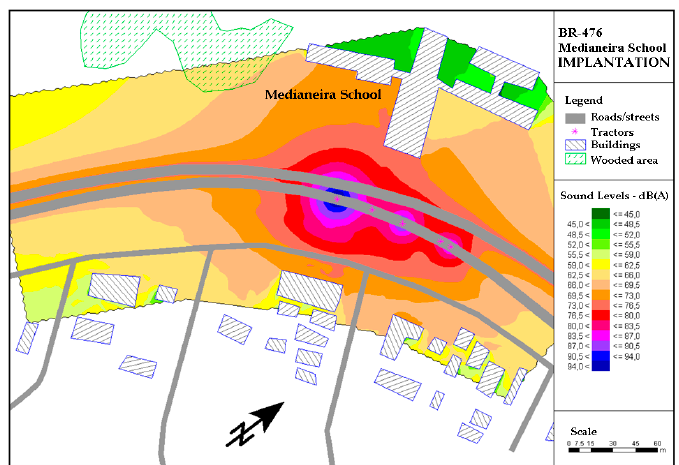
Figure 2. Simulation of noise levels in the implementation phase of the highway urbanization project: Earthmoving works in the surroundings of Medianeira School.